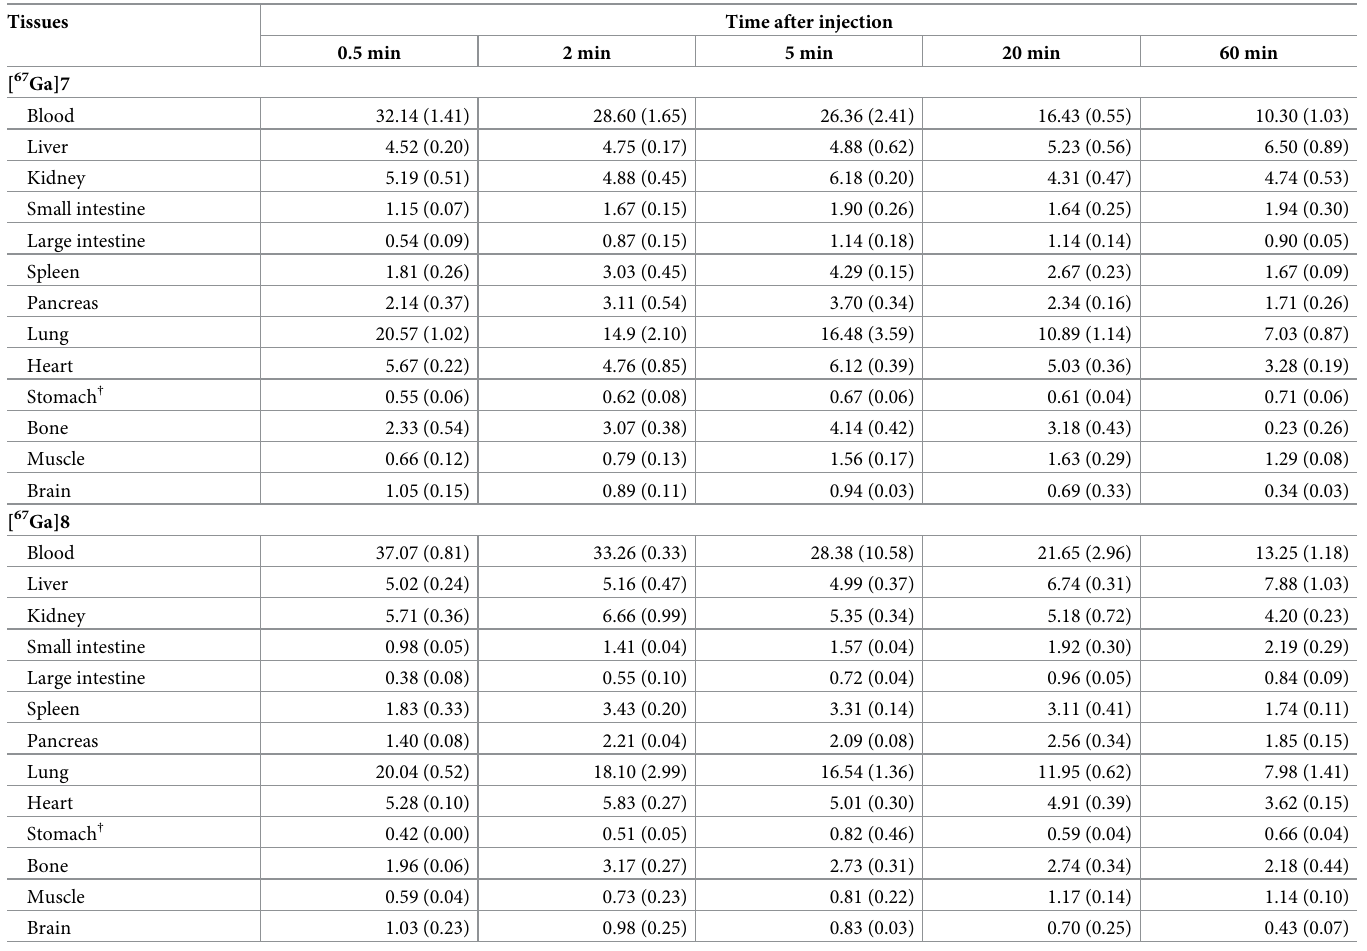
Data were presented as %injected dose/gram tissue. Each value represents mean (SD) for three mice. † presented as